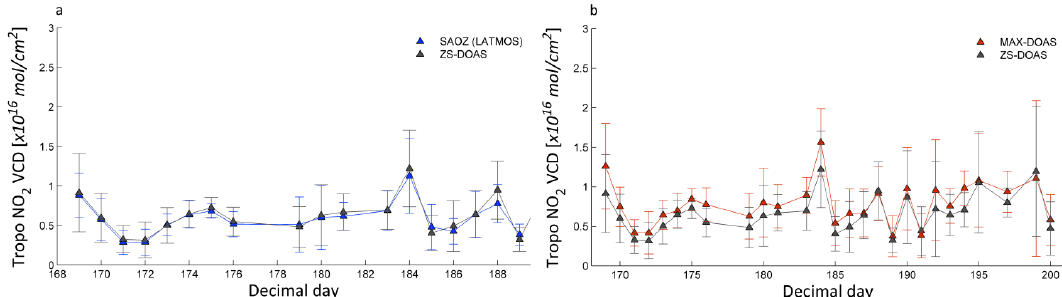
Figure 8. TVCD daily mean time series for (a) ZS-DOAS and SAOZ, and (b) ZS-DOAS and MAX-DOAS,